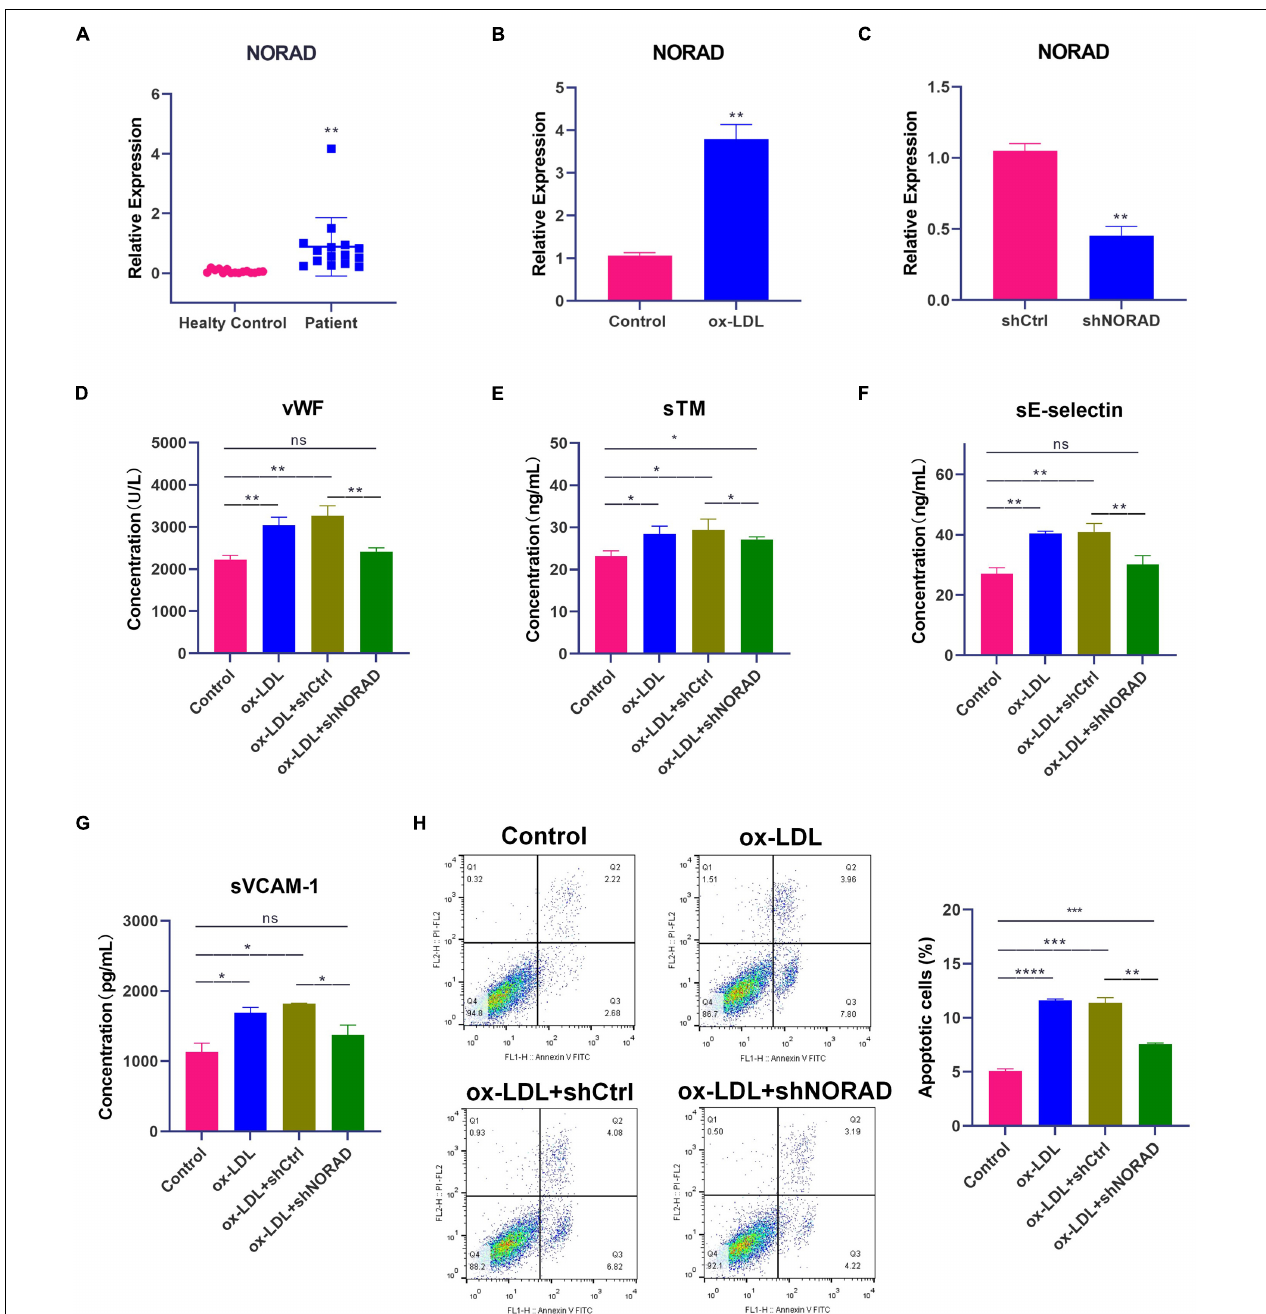
FIGURE 1 | Knockdown of lncRNA NORAD attenuates ox-LDL-induced vascular endothelial injury. (A) The level of lncRNA NORAD in serum of healthy controls ( N = 15) or CAD patients ( N = 15). (B) The level of lncRNA NORAD in HUVECs treated with or without ox-LDL. (C) The level of lncRNA NORAD in HUVECs transfected with control shRNA or shRNA-targeting lncRNA NORAD. (D–G) The level of vWF (D) , sTM (E) , sE-selectin (F) , and sVCAM-1 (G) in HUVECs detected by ELISA. (H) Representative images of flow cytometric apoptosis assay in HUVECs. The bar graph showed the quantification of apoptotic cell number in each group. shCtrl, control shRNA; shNORAD, shRNA-targeting lncRNA NORAD. N = 3 except in panel (A) . * p < 0.05, ** p < 0.01, *** p < 0.001, **** p < 0.0001.